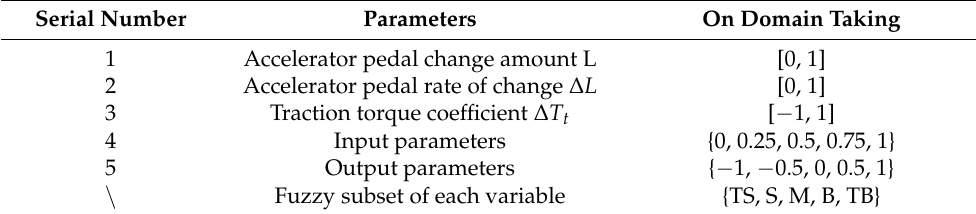
Table 3. Fuzzy controller parameter settings.